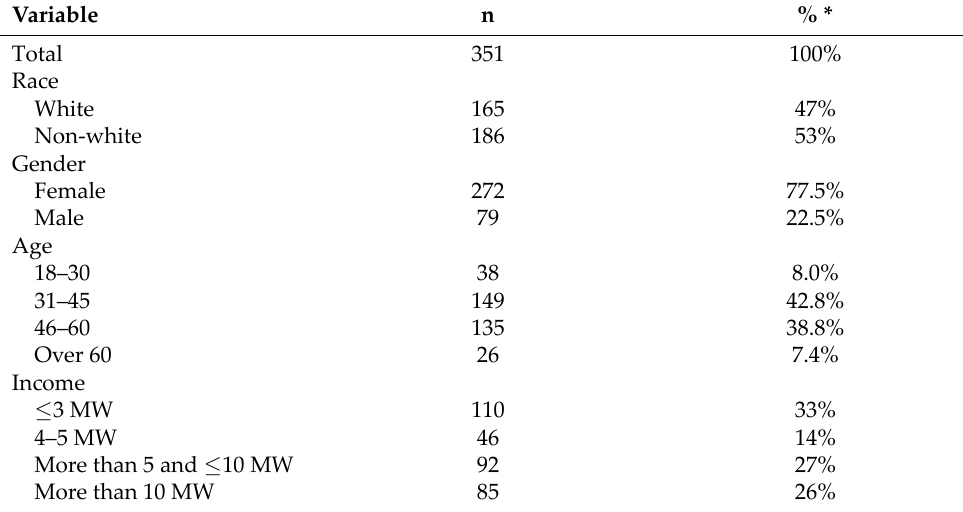
Table 2. Socio‑demographic data on IFF/Fiocruz healthcare workers tested for SARS‑CoV‑2 during the Omicron